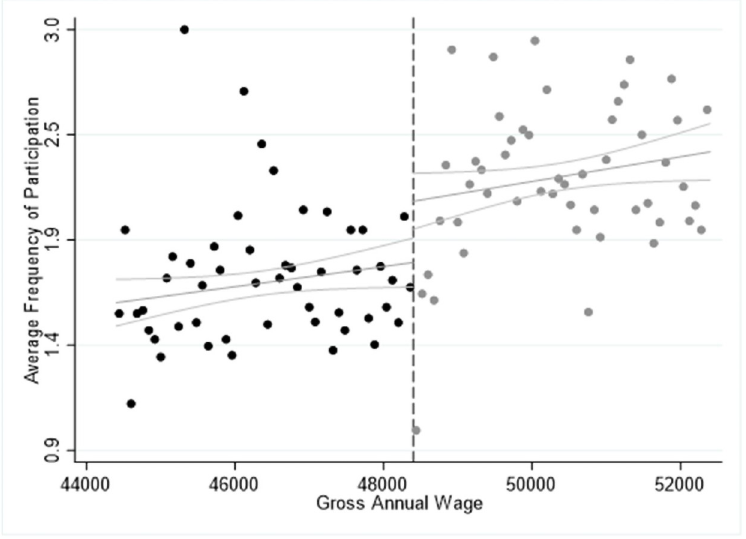
Fig 3. Sharp RDD estimates for participation in practising artistic activities using the salary threshold of 48,400 € in 2015.